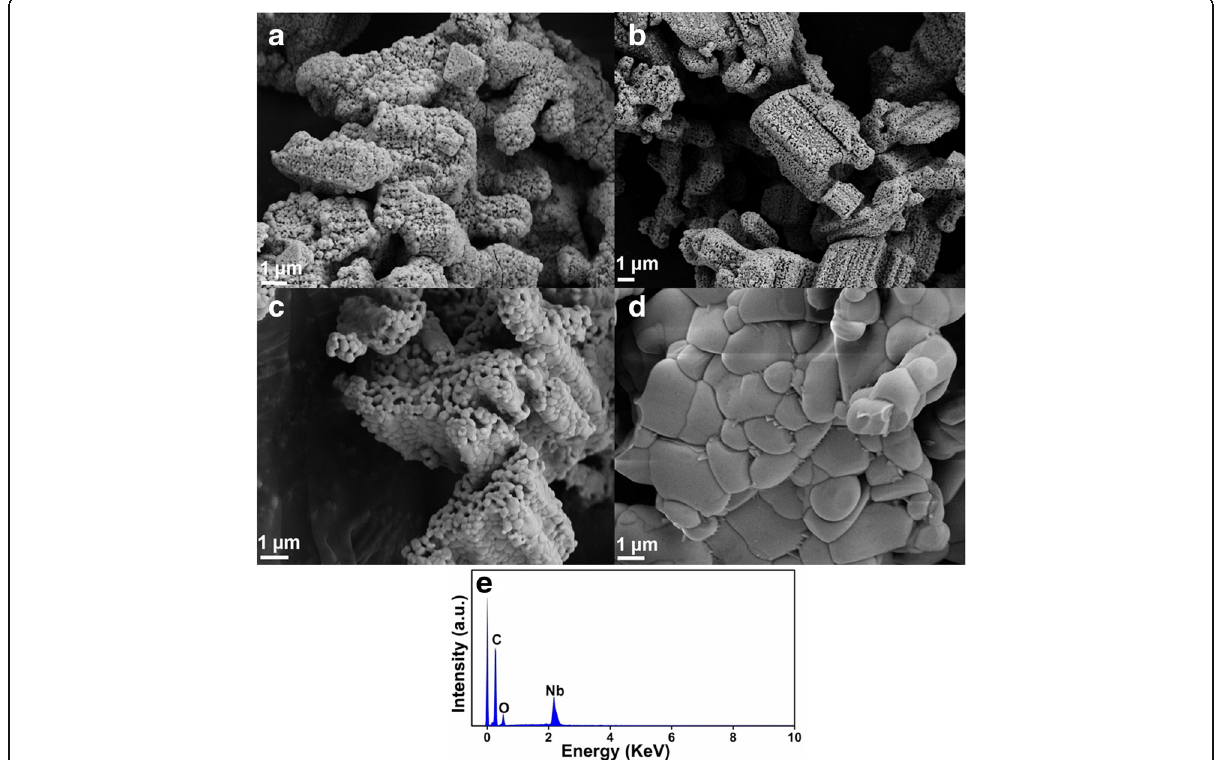
Fig. 2 SEM images of LiNb 3 O 8 powders calcined at a 700°, b 800°, c 900°, and d 1000 °C, respectively. e EDS spectrum of LiNb 3 O 8